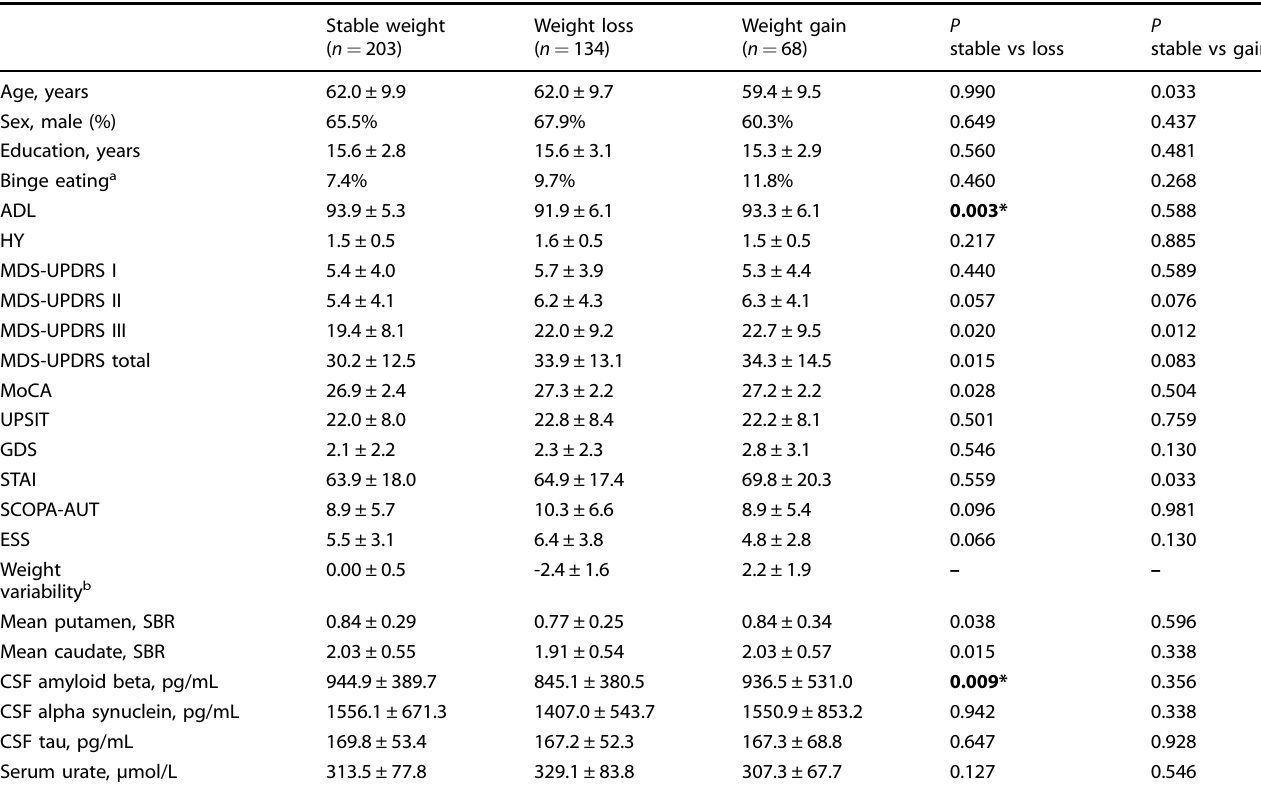
Table 2. Baseline differences of de novo Parkinson ’ s disease patients with subsequent stable weight, weight loss or weight gain after fi ve years of